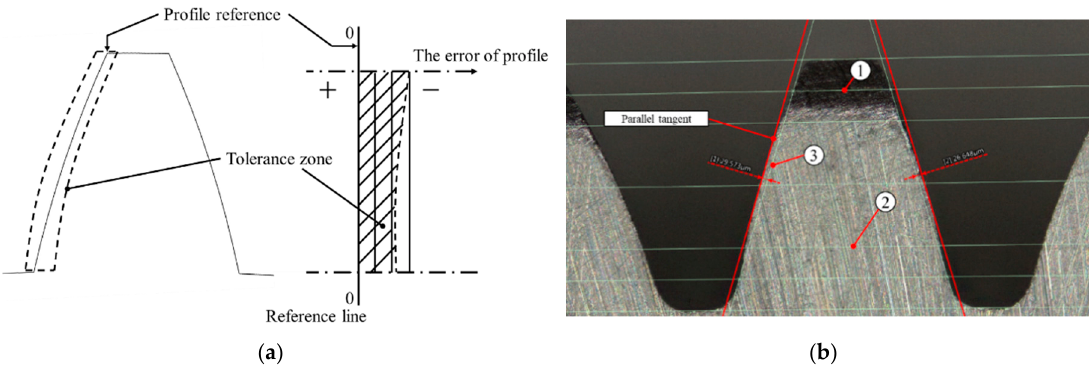
Figure 13. Measure of gear. ( a ) Industry gear profile tolerance [25]. ( b ) Measurement diagram; the distance of auxiliary line 3 to the parallel tangent is the wear amount.